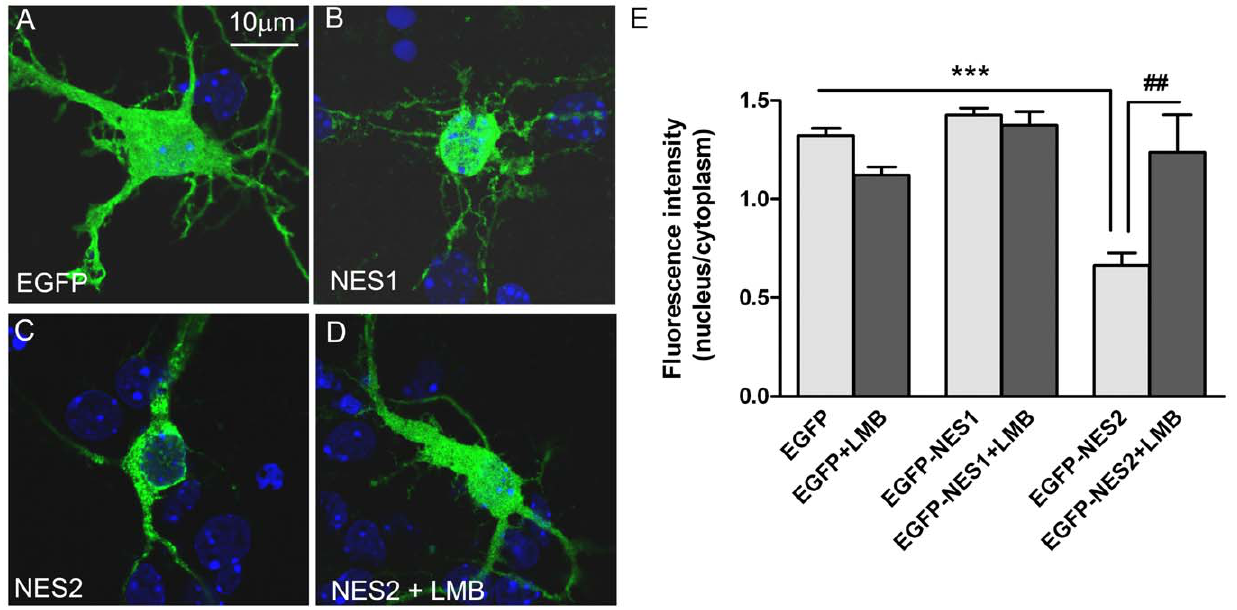
Figure 2. Activity of the putative nuclear export sequences (NESs) 1 and 2, with or without leptomycin B (LMB) treatment. ( A–D ) Representative single optical sections acquired by confocal microscopy of neurons expressing NES1 or NES2 fused to green fluorescent protein (EGFP). Cultured neurons were transfected at 2 DIV with expression plasmids for EGFP (A), EGFP-NES1 (B), or EGFP-NES2 (C and D) and after 16 h were treated with or without 20 nM LMB for 3 h. EGFP fluorescence was analyzed by confocal microscopy. The relative fluorescence intensity in the nucleus versus the cytoplasm was evaluated. In the absence of LMB (C) NES2 was enriched in the cytoplasm. Nuclear NES2 localization was increased in the presence of LMB (D), indicating that the signal of active nuclear exports in the Ngn3 is the NES2. ( E ) Quantification of the subcellular localization of Ngn3 in the cell nucleus versus the cytoplasm. Randomly selected fields containing cells counterstained with DAPI were digitalized and the Mean Gray Value for Ngn3 immunostaining was measured in the nuclei and cytoplasm areas using ImageJ 1.37 v software. The graphs show the mean + s.e.m. of the relative fluorescence intensity in nucleus versus cytoplasm. At least 70 cells from three experiments were counted for each experimental condition. Significance levels were determined using a Student t-test; *** p , 0.001 versus EGFP expressing neurons values; ### p , 0.001 of EGFP-NES2 transfection treated with LMB versus the same transfection not treated with LMB.